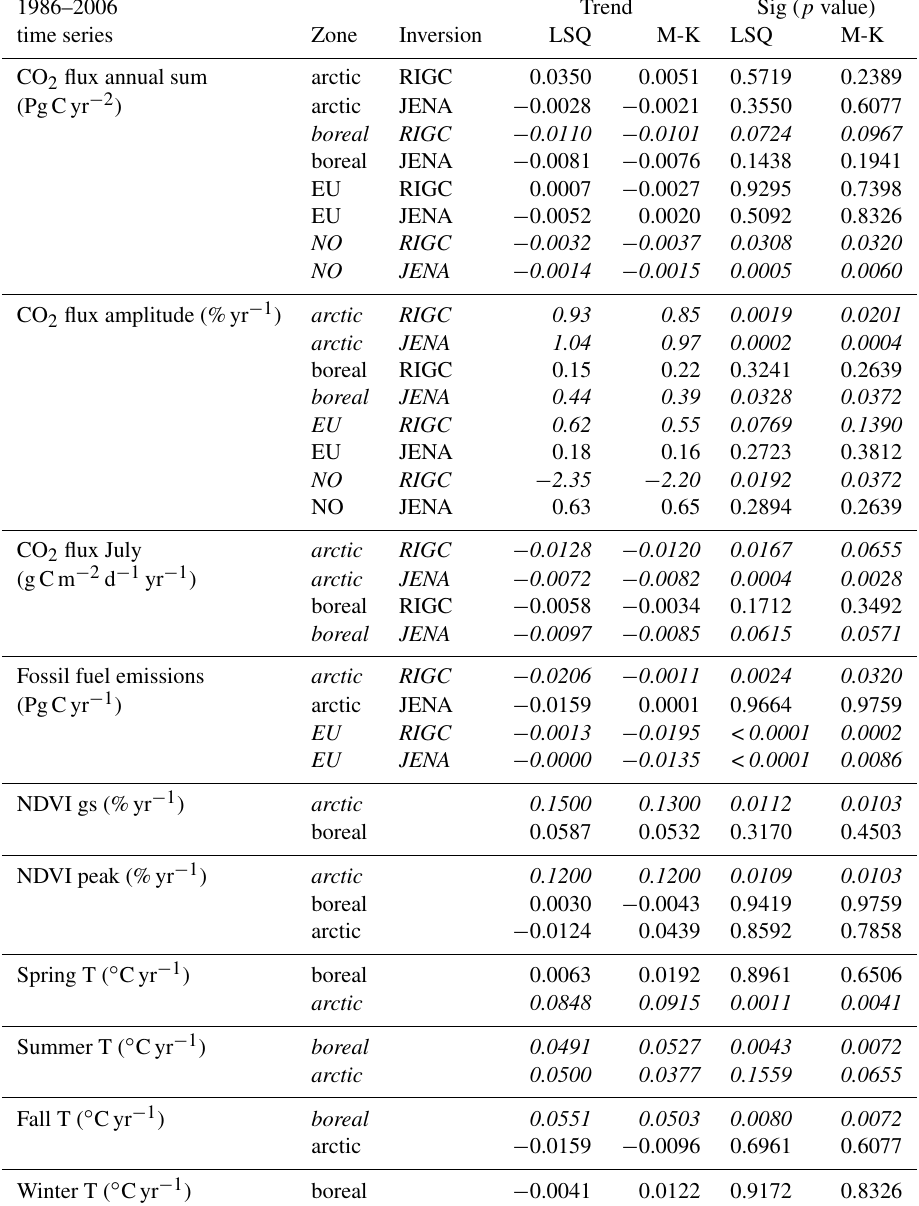
Table 2. Trend and significance statistics for time series of interest, from 1986 through 2006. “Trend” is the slope from linear least squares (LSQ) and Mann–Kendall (M-K) Sen slope; likewise, “Sig ( p value)” is the p value from LSQ and M-K tests. Arctic zone and boreal zone are for BNA + BA; EU: Europe, NO: northern ocean. Italic values indicate 90% significance level ( p value 0.1 in at least one statistical